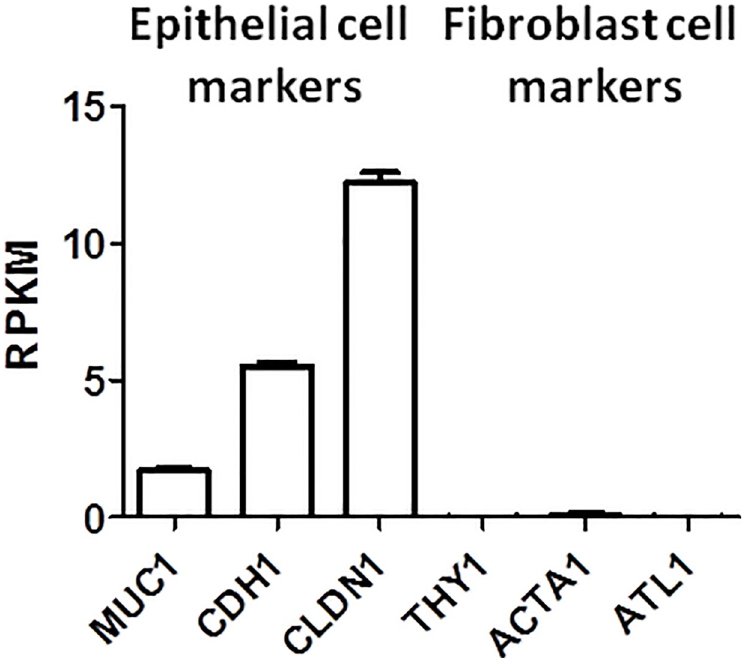
Fig 9. mRNA expression of cell markers. The epithelial cell markers Mucin 1 (MUC1) , Cadherin 1 (CDH1) , and Claudin 1 (CLDN1) and the fibroblast markers Thy-1 Cell Surface Antigen (THY1) , Actin Alpha 1 Skeletal Muscle (ACTA1) , and Atlastin GTPase 1 (ATL1) were measured to verify the homogeneity of the analysed nasal epithelial cell cultures.